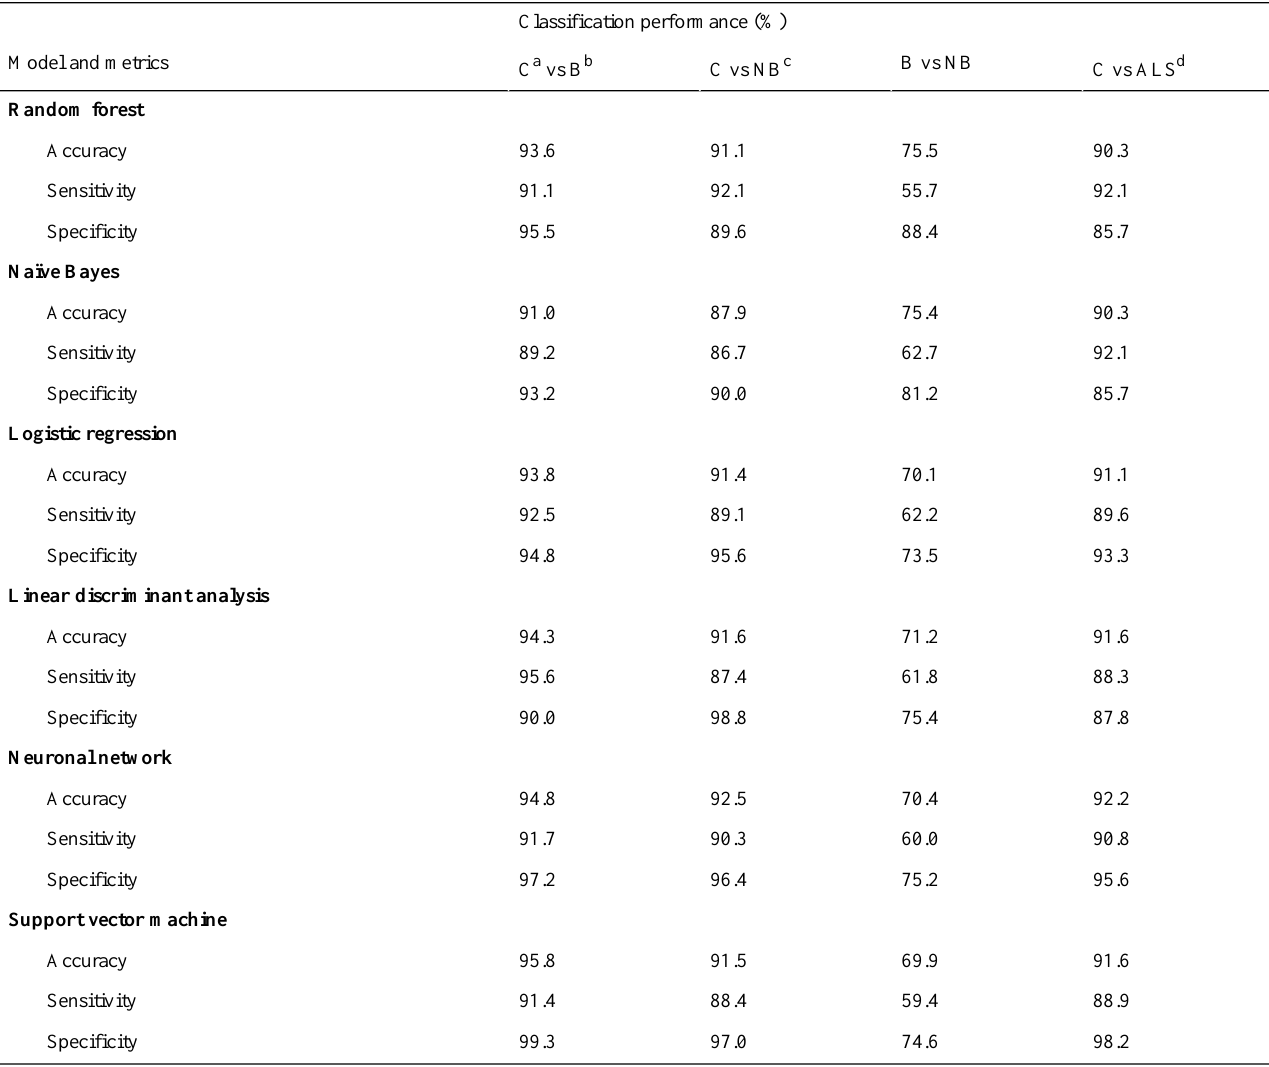
Table 1. Classification performance of the supervised models with the classification threshold set at 50%. Classification performance